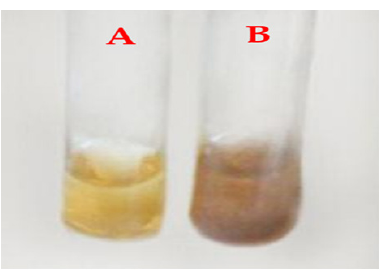
Fig. 2 .UV-Visible absorption spectrum of silver nanoparticles synthesized by Pseudomonas sp . (B) 3